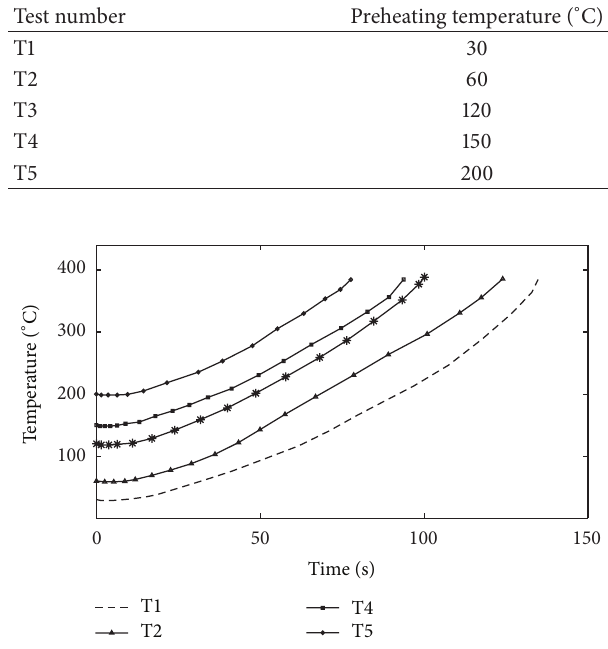
Figure 5: Effect of the preheating temperature on the time for reaching the maximum temperature of 384 ∘ C.